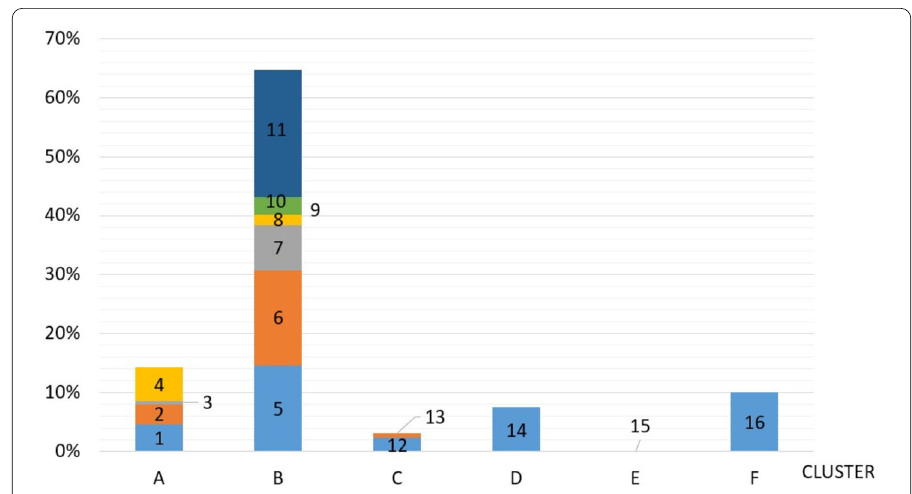
Figure 1 Groups (numbers as in the left column of the Table 2) and six clusters of the electrical grids failures’ causes in 2010